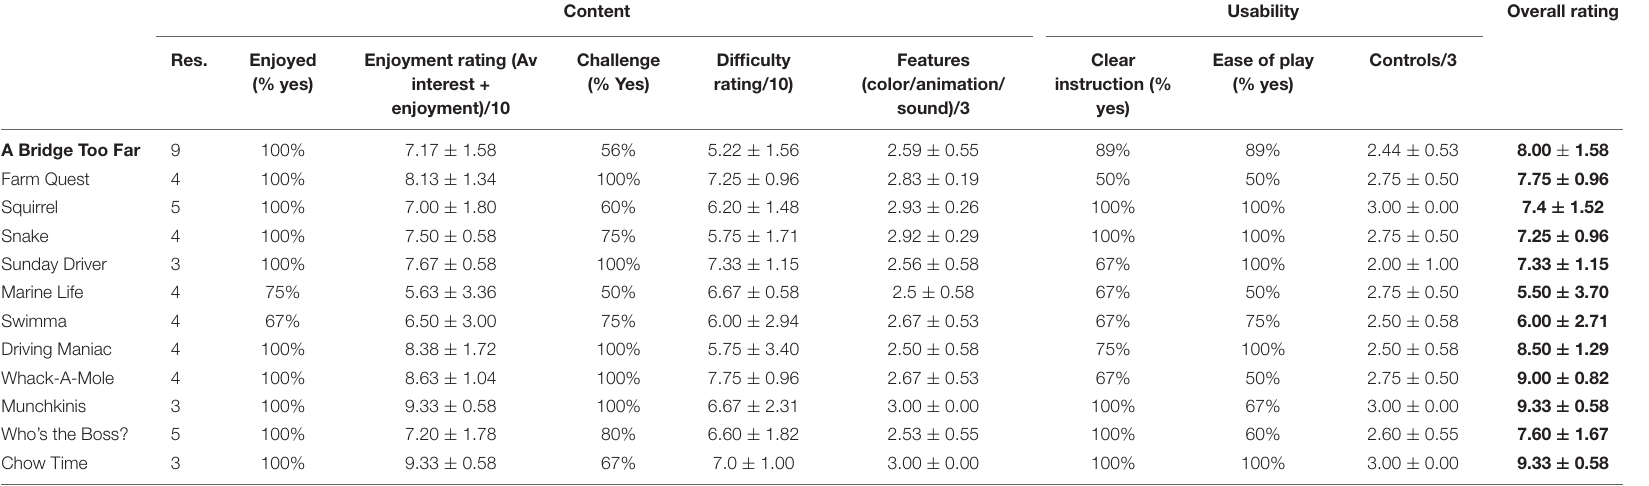
TABLE 6 | Individual game feedback, post-modification.